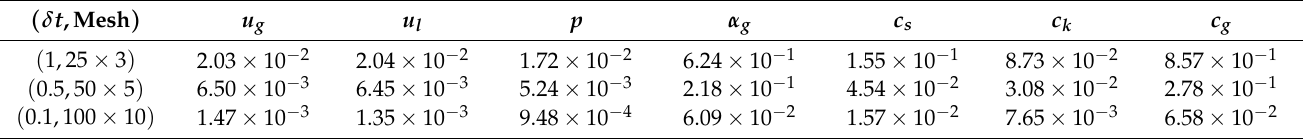
Figure 9. Convergence with respect to δ t and mesh size for the case described in Section 5.2 (see Table 5 for the time step and mesh size pair): log–log plot of the error for each unknown (note that the curves for u l and u l overlap). Table 5. L 2 error with respect to the reference solution provided with time step δ t = 0.05, 200 × 20 uniform mesh, and α = 0.0005 for numerical simulation in Section 5.2 at T =